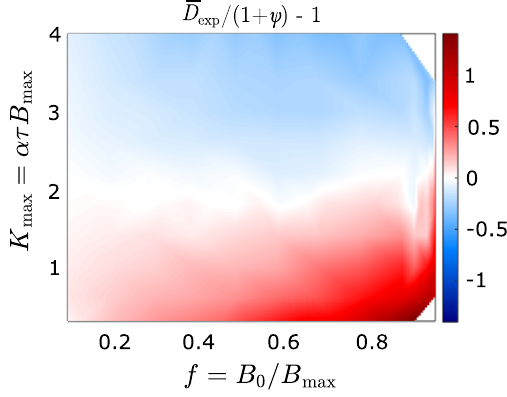
¯ D to the exp max